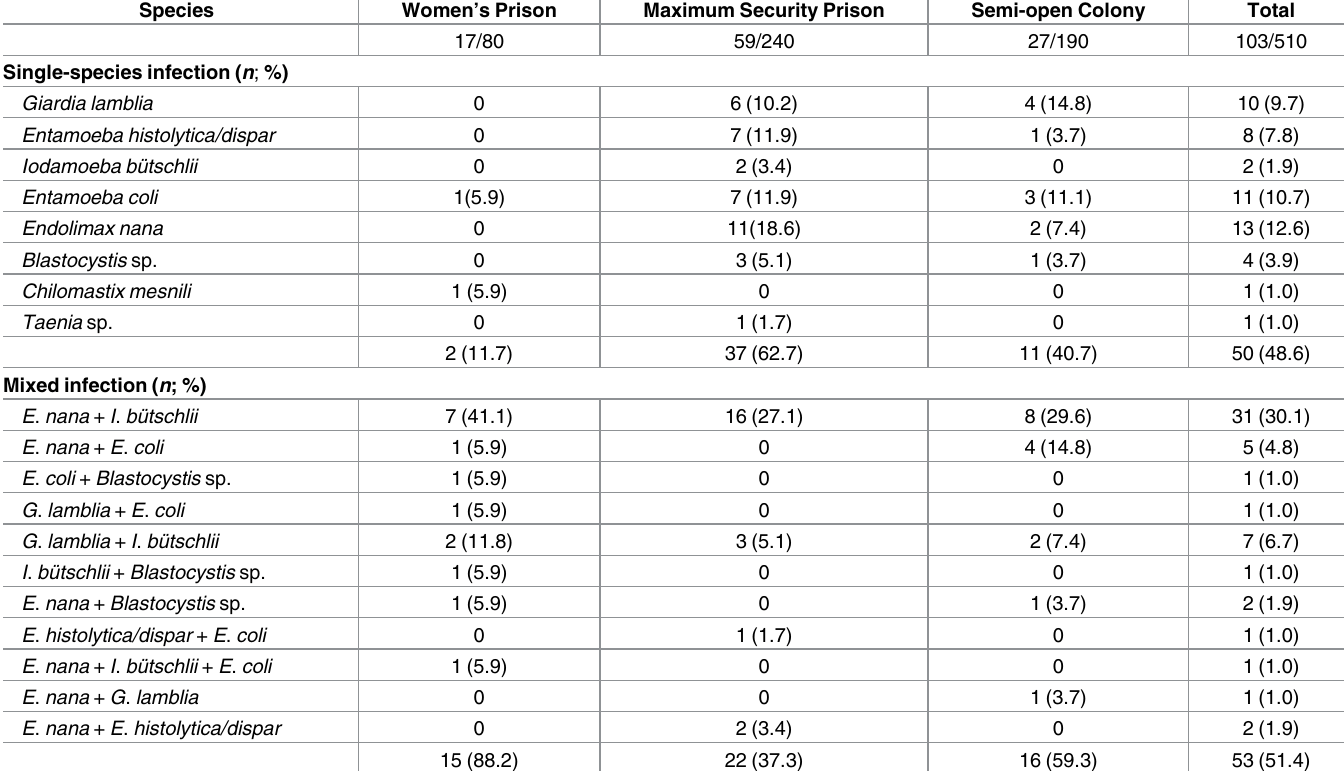
Table 2. Casesof single- and mixed-species intestinal infection among positively diagnosed inmates, by prison facility. Mato Grosso do Sul, Mid- west Brazil ( n =